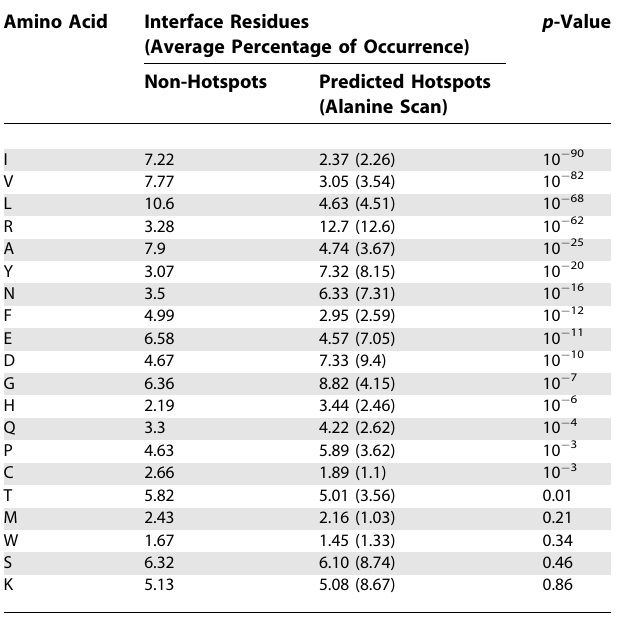
Table 1. Position Occupancy in Hotspots versus the Rest of the Interface Amino Acid Interface Residues (Average Percentage of Occurrence)